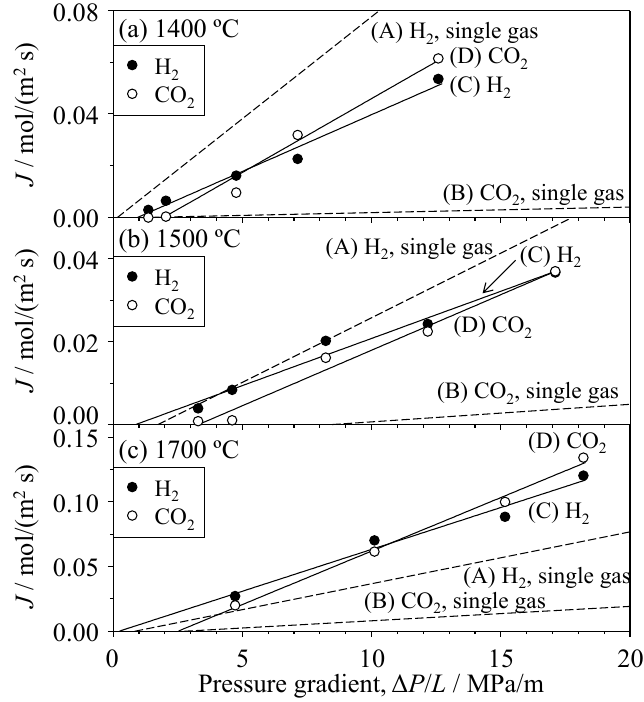
Figure 12. Flux of H 2 and CO 2 gases for the mixed gas of 50 vol % H 2 –50 vol % CO 2 through SiC ceramics hot-pressed at ( a ) 1400 °C; ( b ) 1500 °C; and ( c ) 1700 °C.